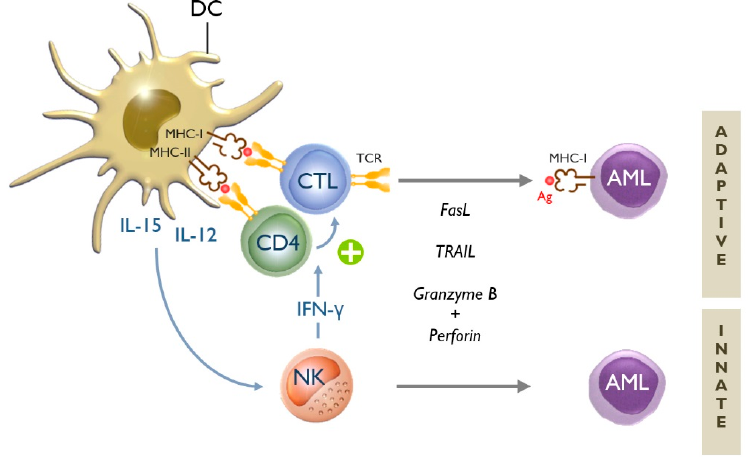
Figure 1. Dendritic cells are key to the induction of adaptive and innate anti-leukemia immunity . Dendritic